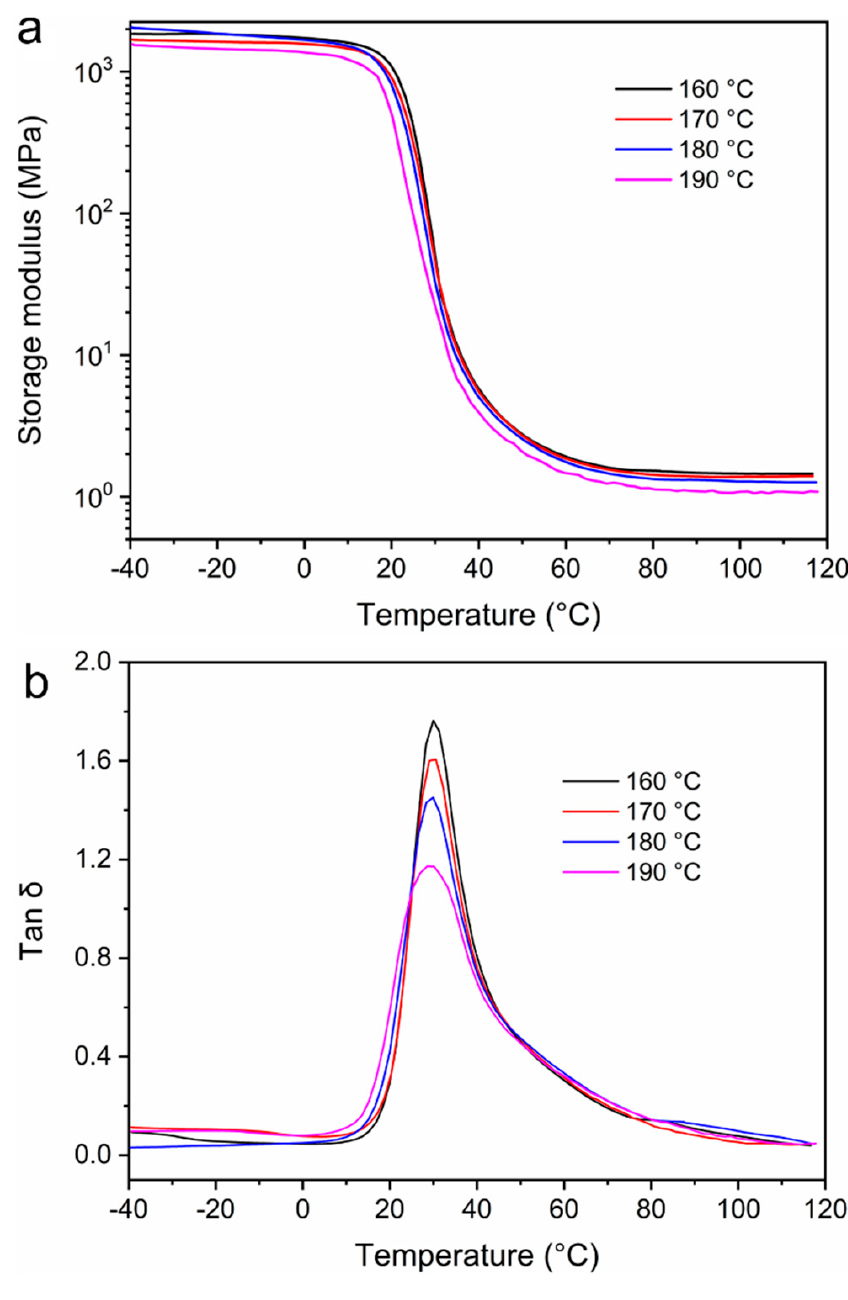
Figure 2. ( a ) Storage modulus plots and ( b ) tan δ plots of epoxy vitrimers prepared by dynamic crosslinking at different temperatures.